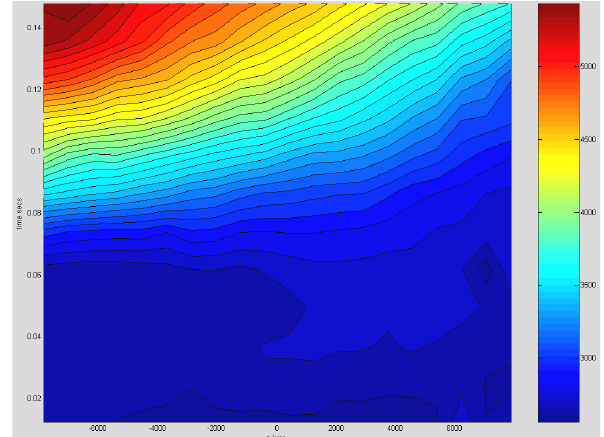
Fig. 11. History of the in phase current J r of the simulation as Fig. 11. a contour plot in the z,t plane, for the case of Ne=5 electrons/cc. Fig. 13. For Ne=5 electrons/cc, the plot of smoothed localised fre- Since J r is normalised to unity for linear growth at the equator at the quency in the z,t plane for the first element only. The develop- saturation amplitude and at the starting frequency, nonlinear growth ment of a marked frequency/ wave number gradient across the GR rates peak at about 1.7 times the linear value. Note that the detailed is noted. Hence the advective term in df/dt is very structure of each element is by no means the same.